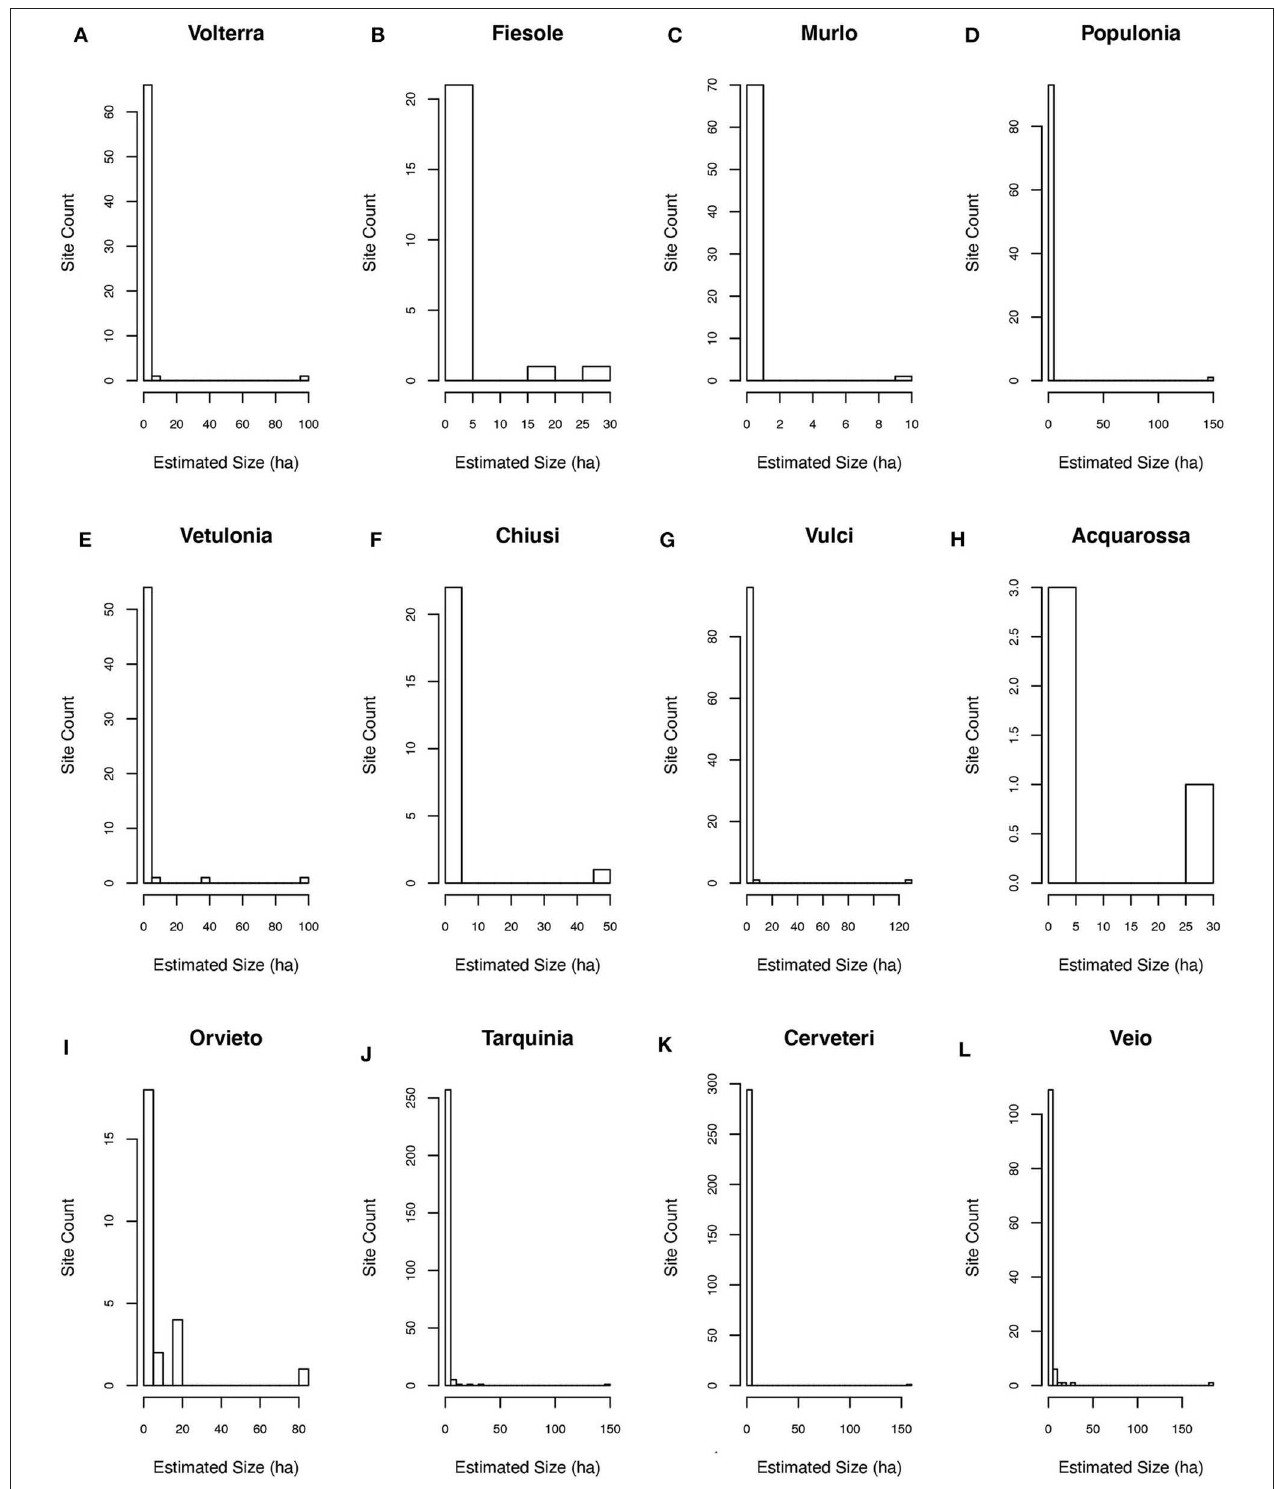
FIGURE 5 | Histograms of settlement size for each city territory for the Archaic period. (A) Volterra, (B) Fiesole, (C) Murlo, (D) Populonia, (E) Vetulonia, (F) Chiusi, (G) Vulci, (H) Acquarossa, (I) Orvieto, (J) Tarquinia, (K) Cerveteri, (L) Veio.